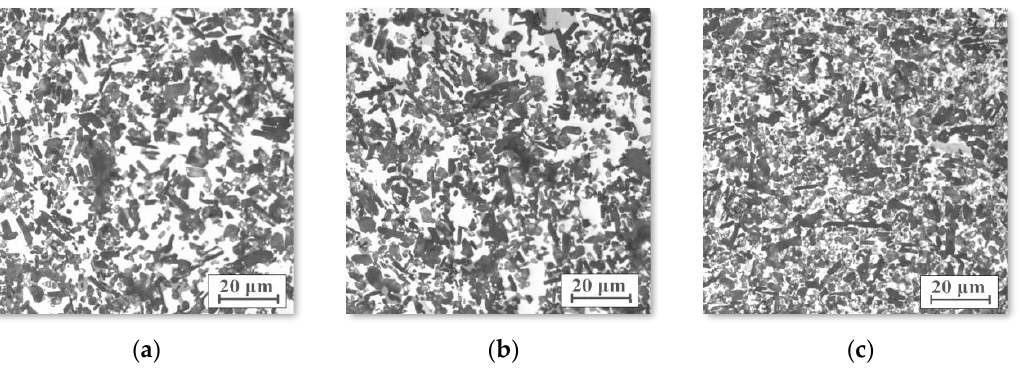
Figure 6 . Microstructure of infiltrated composites reinforced with porous ceramics sintered at ( a ) 1200 °C, ( b ) 1400 °C, and ( c ) 1600 °C. ( a ) 1200 ◦ C, ( b ) 1400 ◦ C, and ( c ) 1600 ◦ C.